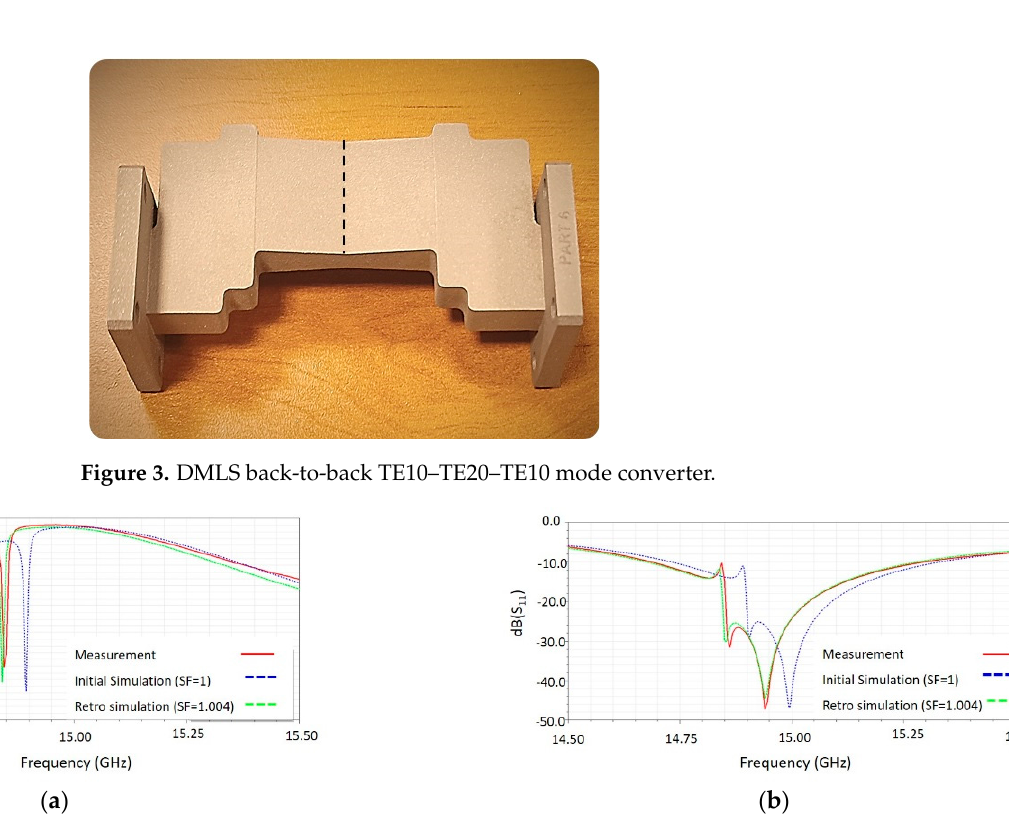
Figure 3. DMLS back-to-back TE10–TE20–TE10 mode converter.